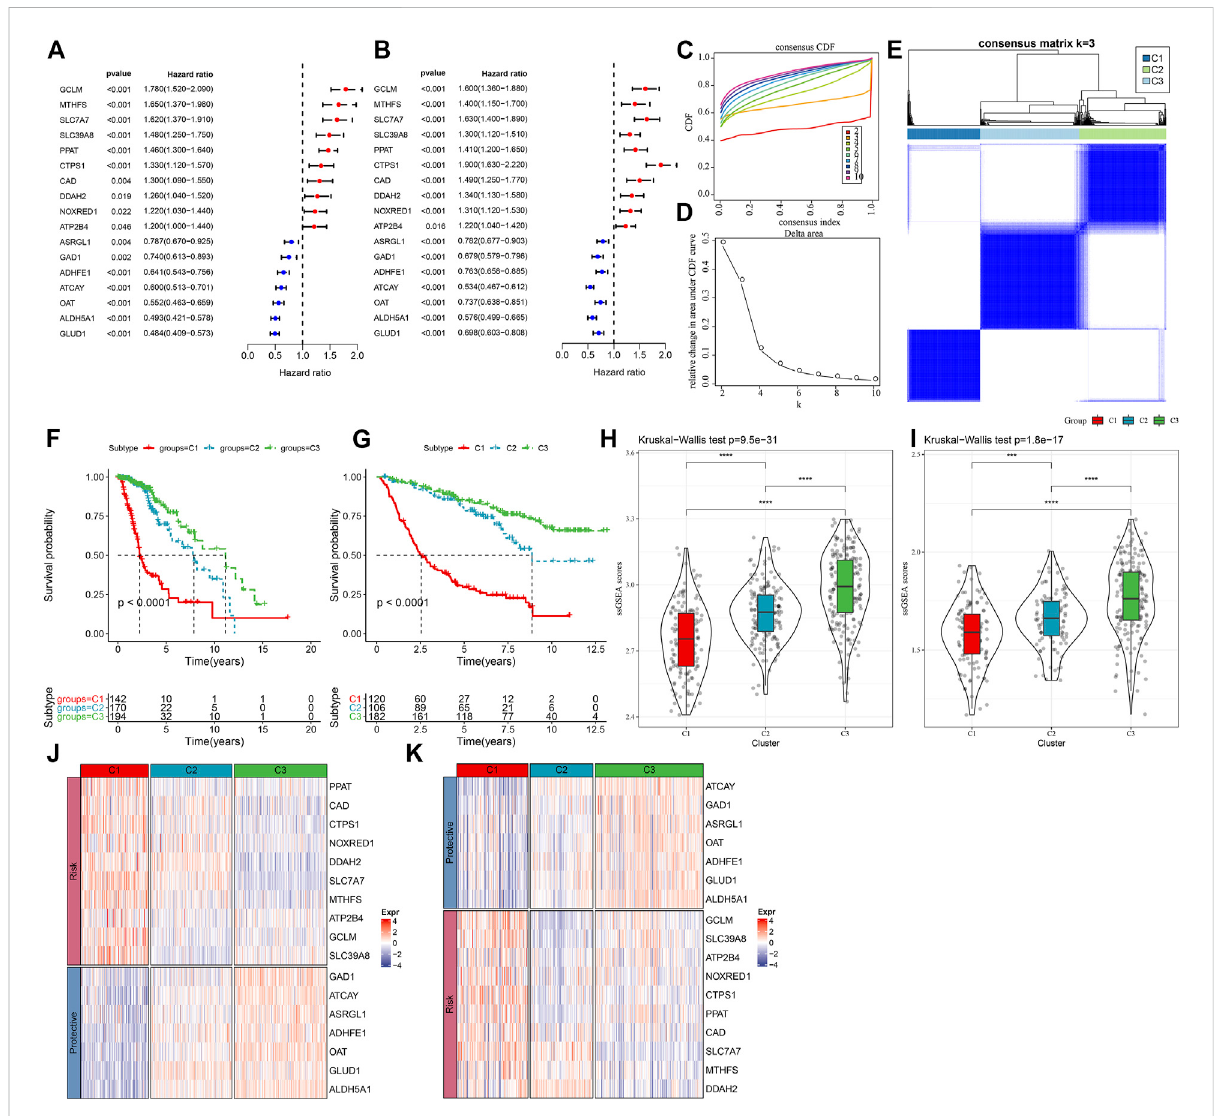
FIGURE 1 Molecular typing in accordance with the glutamine metabolism genes (A) Forest plot of glutamine metabolism crossover genes in TCGA dataset; (B) Forestplotofglutamine metabolismcrossovergenesinCGGAcohort. (C) CDFcurveofTCGA datasetsamples. (D) CDFDeltaareacurve of TCGA dataset samples. Delta area curve of consensus clustering, indicating the relative change in area under the CDF curve for each category number k in comparison with k – 1. The horizontal axis is for the category number k, and the vertical axis is for therelative change in area under theCDFcurve. (E) Heatmapofsampleclusteringatconsensusk=3. (F) KMcurvesoftherelationshipbetweentheprognosisofthethreesubtypesin the TCGA dataset. (G) KM curves of the relationship between the prognosis of the three subtypes in the CGGA dataset. (H) Differences in glutamine metabolism scores between different molecular subtypes in the TCGA-LGG cohort. (I) Differences in glutamine metabolism scores in different molecular subtypes in the CGGA dataset. (J) Heat map of expression of prognostically signi fi cant glutamine metabolism-related genes in different subtypes in the TCGA dataset. (K) Heat map of expression of prognostically signi fi cant glutamine metabolism-related genes in different subtypes in the CGGA